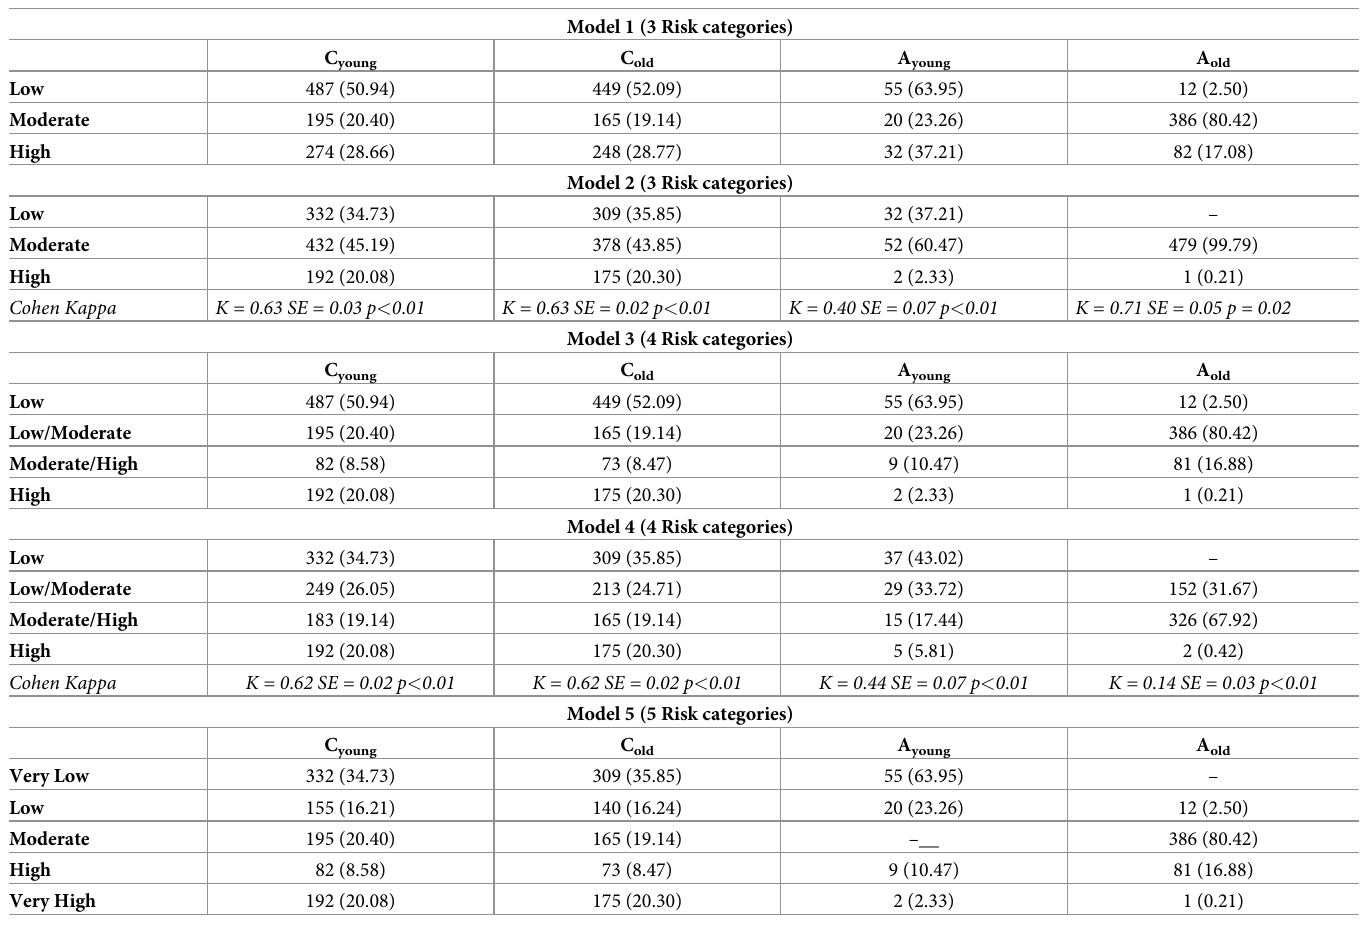
Table 3. Caries risk in the four samples using the five Cariogram